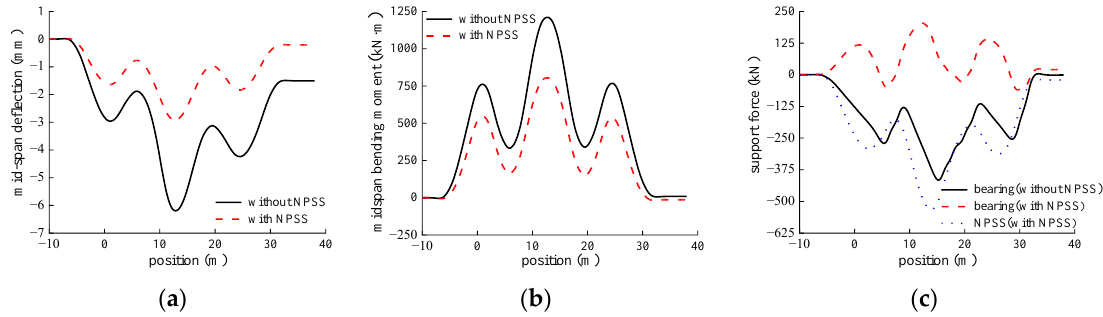
Figure 12. The calculated results with and without NPSS. ( a ) Midspan deflection; ( b ) midspan bending moment; ( c ) support force.